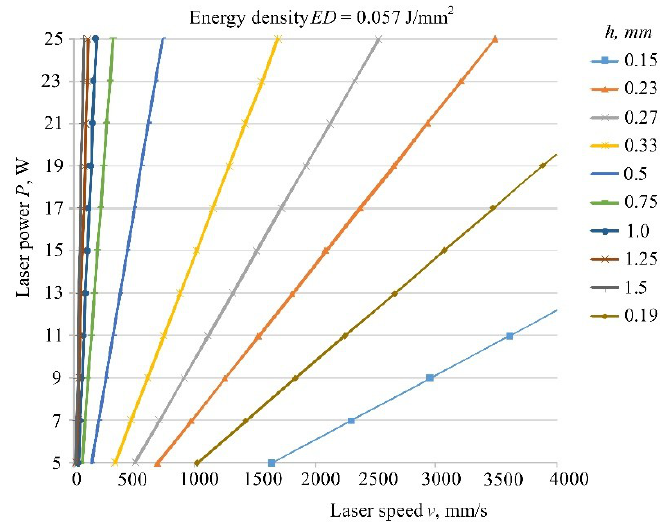
Figure 17. Selection of processing parameters in SLS.